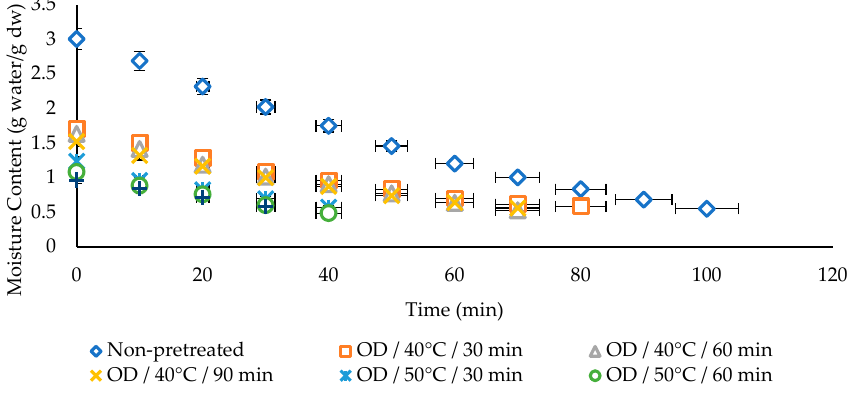
Figure 1. Drying behaviors of kumquat slices.